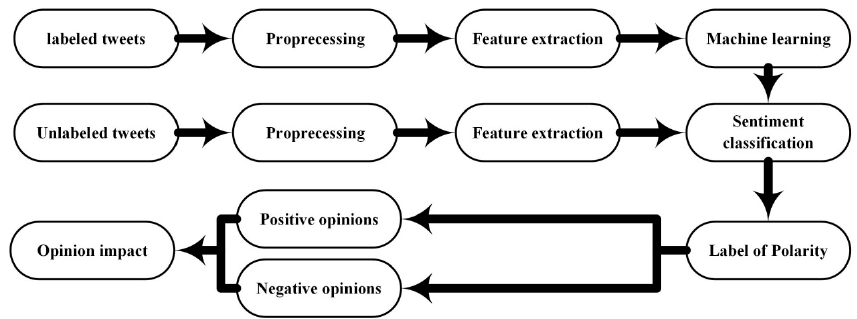
Figure 1. The operation flow of Twitter sentiment analysis [14].